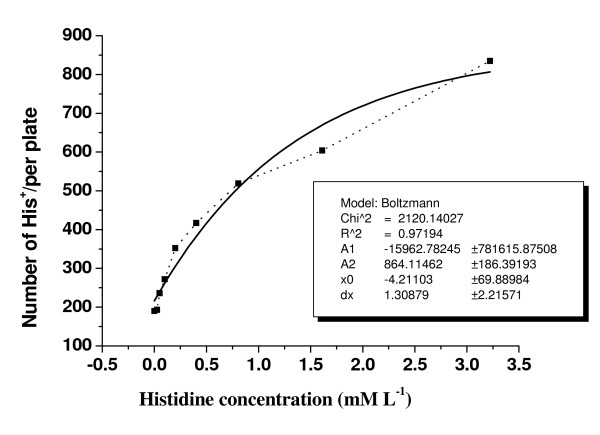
Number of his+ revertants per plate increased exponentially with the histidine concentration in the medium. Broken line: experimental data. Solid line: sigmoidal fit curve by Origin 6.0, model Boltzmann.